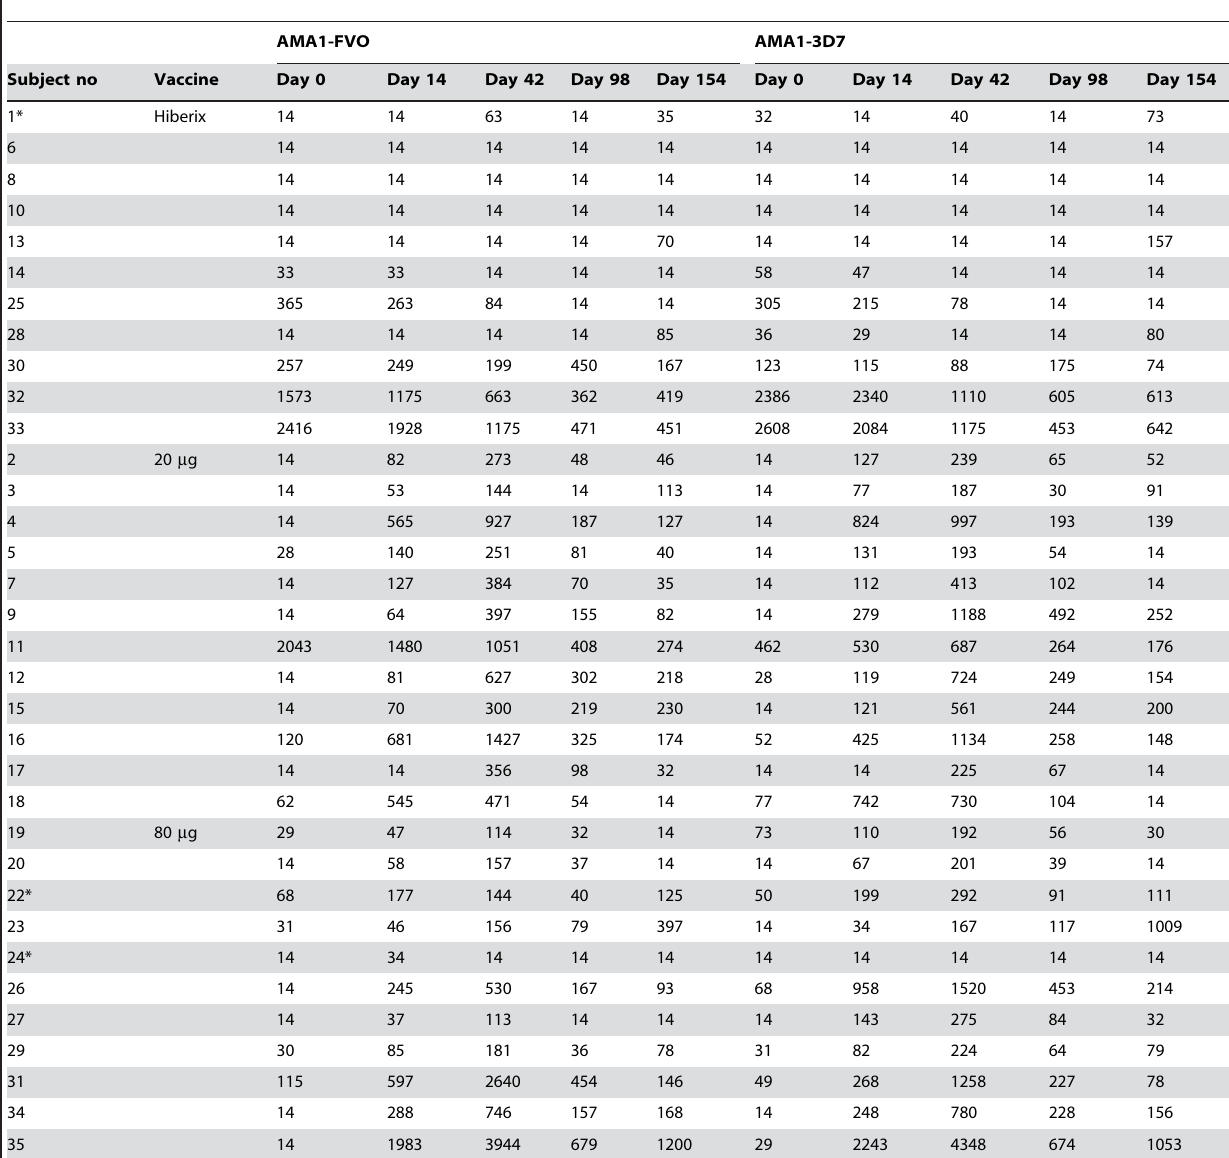
Table 2. ELISA antibody values in plasma from volunteers on selected time points.